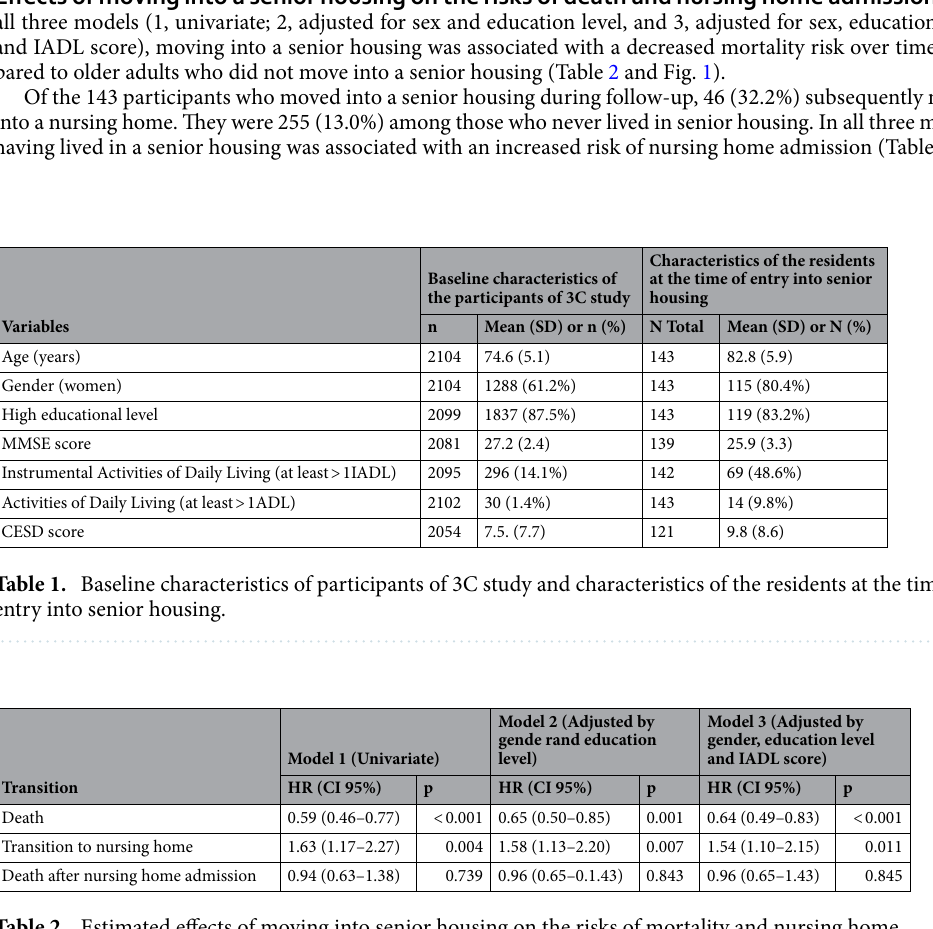
Table 2. Estimated effects of moving into senior housing on the risks of mortality and nursing home admission, illness-death model. 3C study (n = 2095).